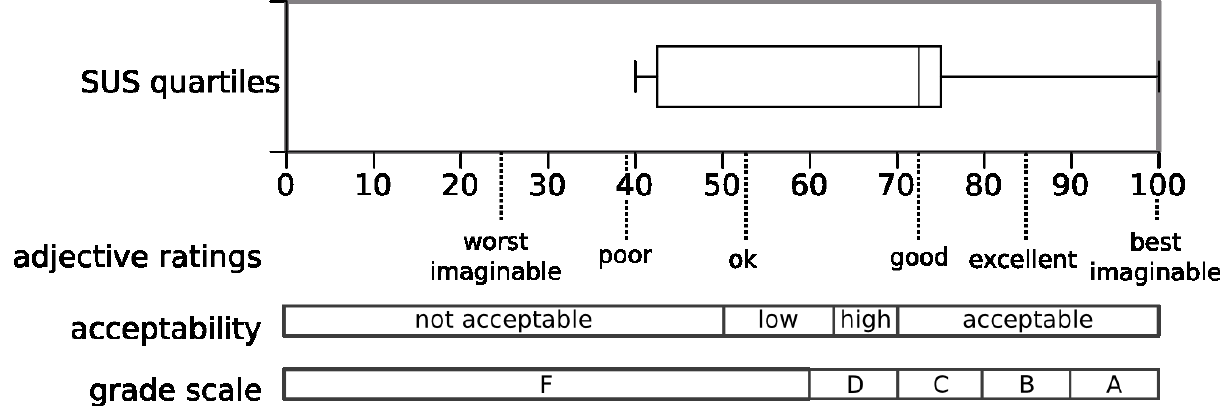
Figure 7. Score of the SUS sub-study [21]. The SUS score (median) was 72.5 (IQR=34.5). Three female and two male members of the nursing staff (N=5), 18-25 years of age (2/5), 26-35 years of age (1/5), 36-45 years of age (1/5), and 46-55 years of age (1/5) voluntarily answered the SUS questionnaire. All were regular nurses working in a full time scheme. The work experience included time spans of under 5 years (2/5), 11-15 years (1/5), and 26-30 years (2/5). Educational levels were Secondary School Level I (2/5) and II